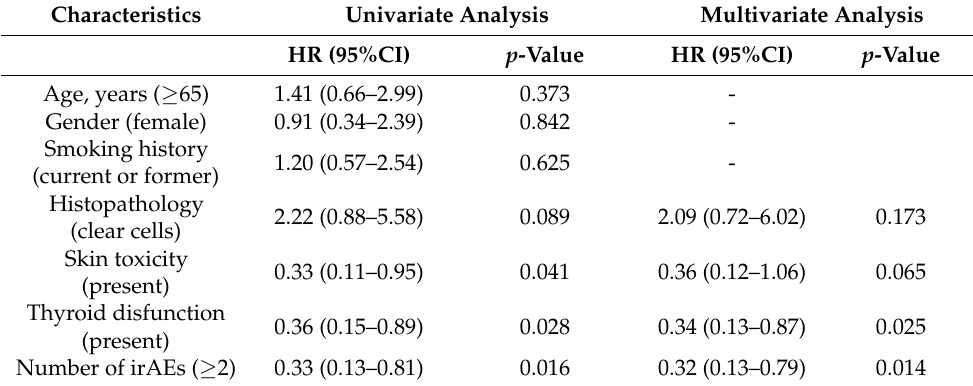
Table 3. Univariate and multivariate analysis of progression-free survival.